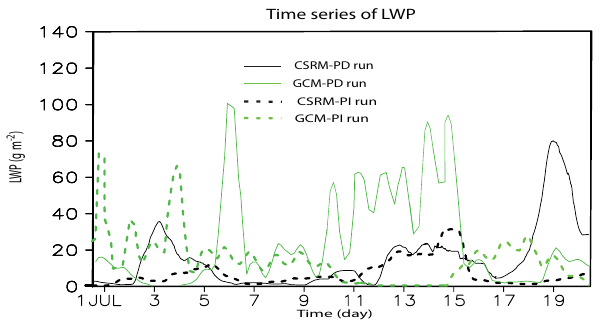
Fig. 7. Time series of LWP (g m − 2 ) averaged over the horizontal domain for the CSRM runs and the GCM